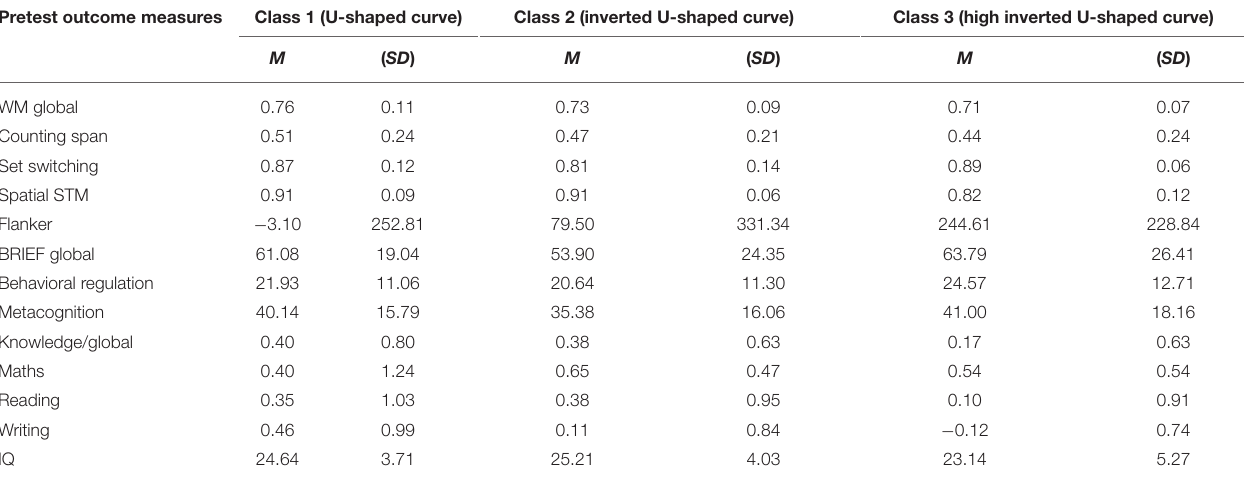
TABLE 5 | Performance for pre-test outcome measures for three trajectory groups (from GMM in VSWM training tasks). Pretest outcome